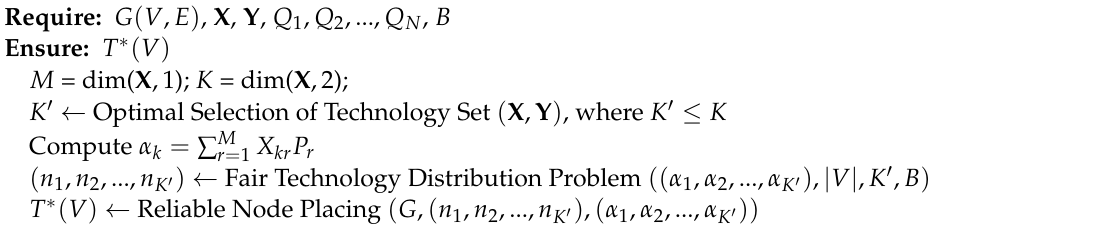
Algorithm 1 Optimal Multiculture Network